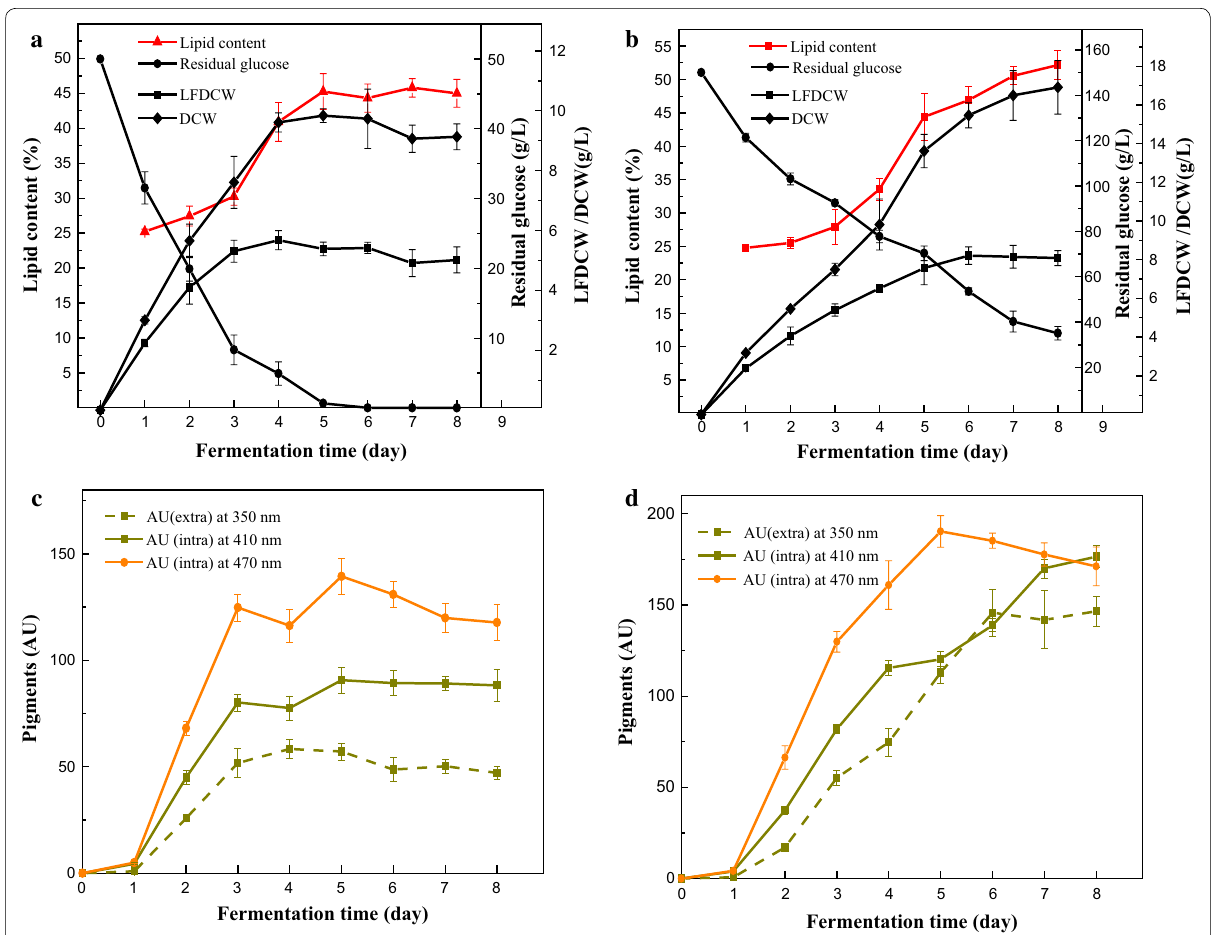
Fig. 2 Time course of lipid content (%), LFDCW (g/L), DCW (g/L), pigment production and residual glucose (g/L) under different IGCs. a , c IGC 50 g/L. b , d IGC 150 g/L = =